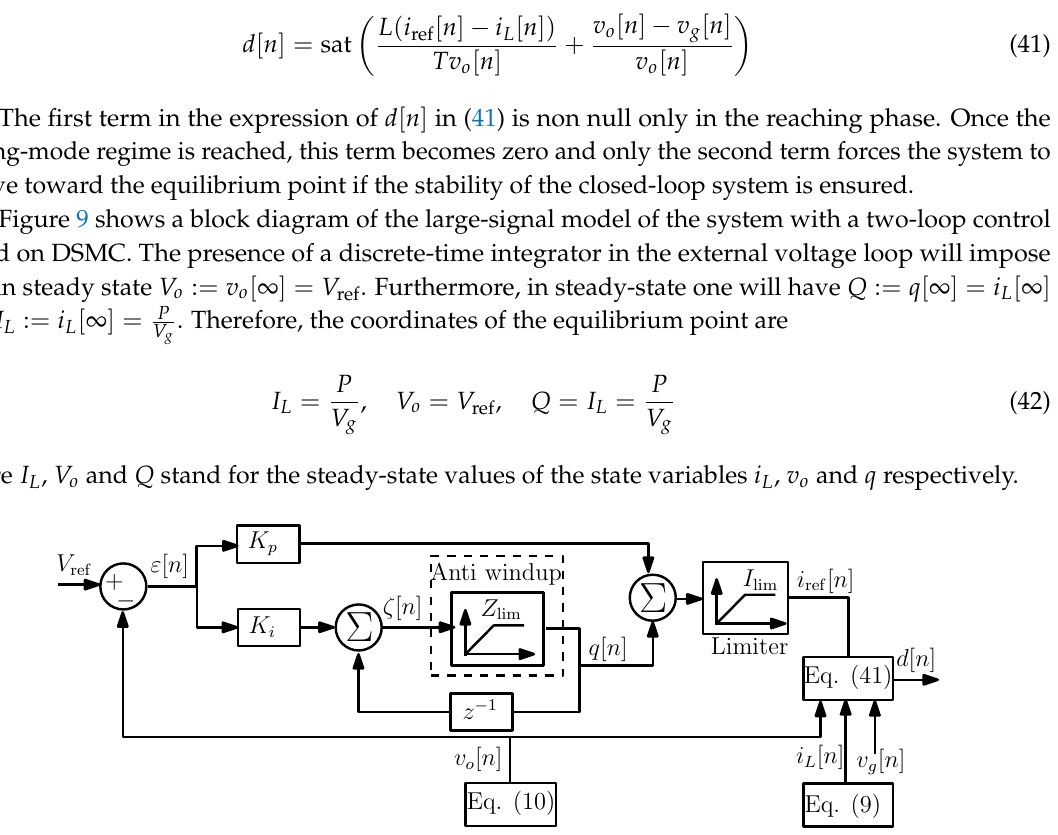
domain small-signal −